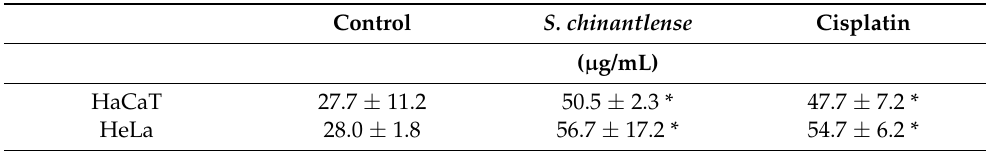
Table 2. Mean concentration of cytoplasmic cytochrome c (μg/mL) in HeLa and HaCaT cell lines induced by S. chinantlense extract or cisplatin at the IC 50 value for 24 h.